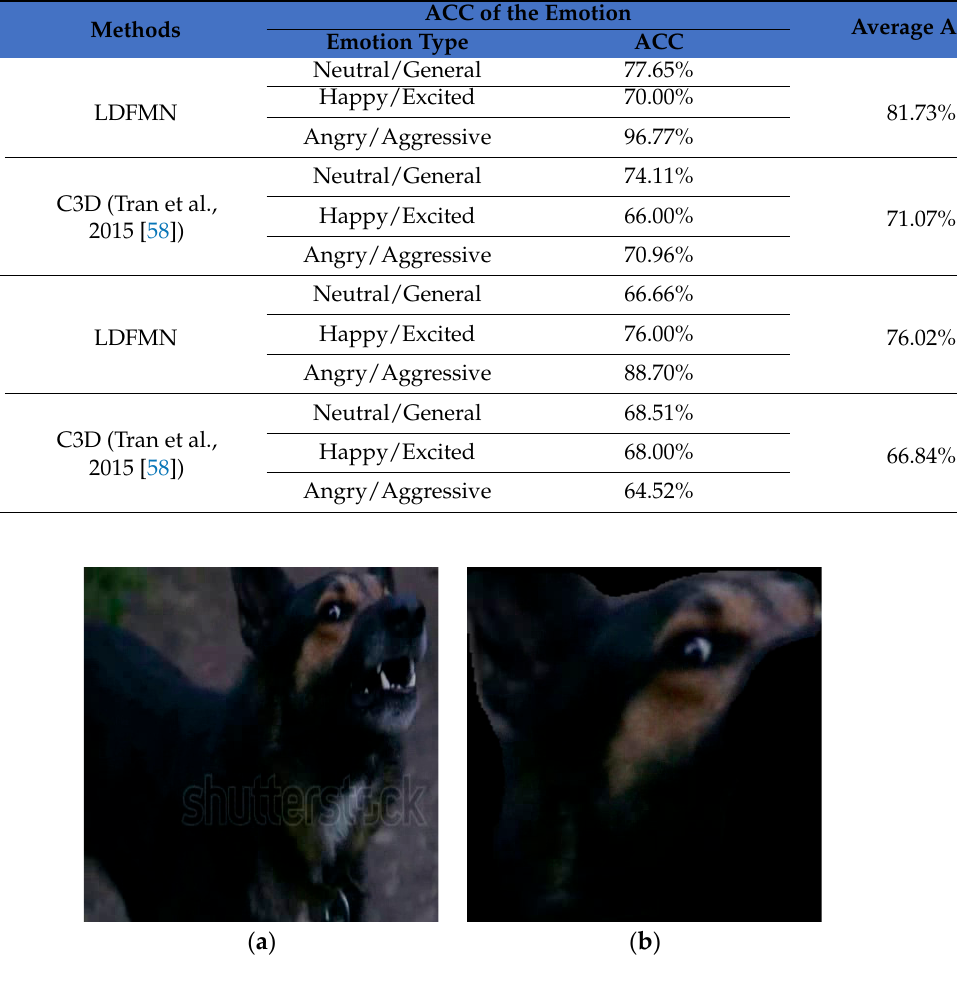
Figure 21. Images before and after background removal. ( a ) Original image; ( b ) After background